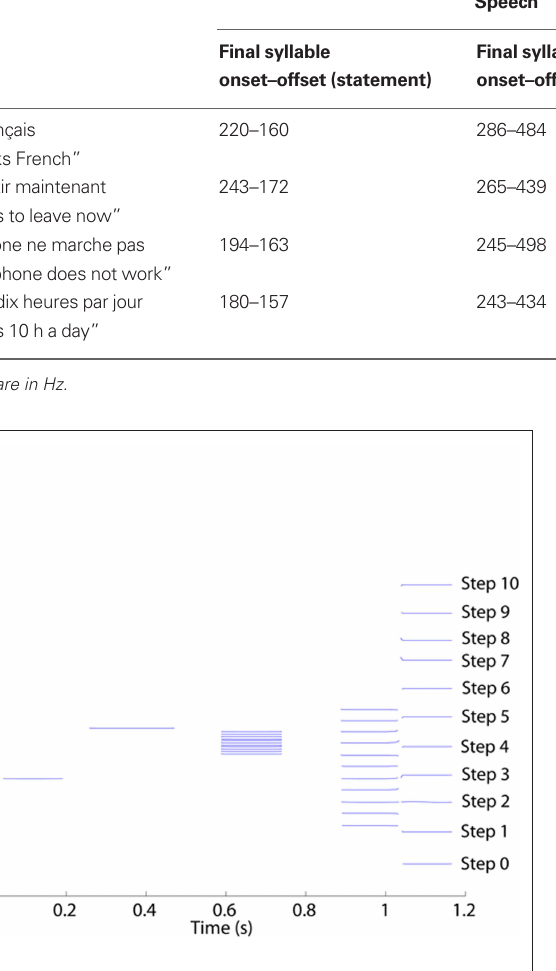
Figure 2 | The fundamental frequency across time for all 11 steps of the tone analog of the sentence “il parle français.” The final syllable is split into two tones. Note that the 11 steps seem more closely spaced in this condition only because they are at the means of the final syllables, which are changing in pitch. Figure 3 | Observed data and logistic regressions for sentence stimuli.